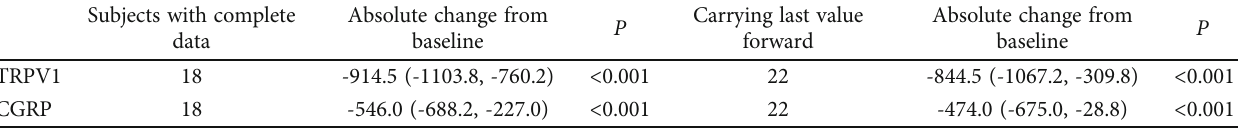
Table 5: Absolute di ff erences in the number of a ff erent fi bers in distal esophageal mucosa at baseline and 12 m after treatment. Subjects with complete Absolute change from P data baseline